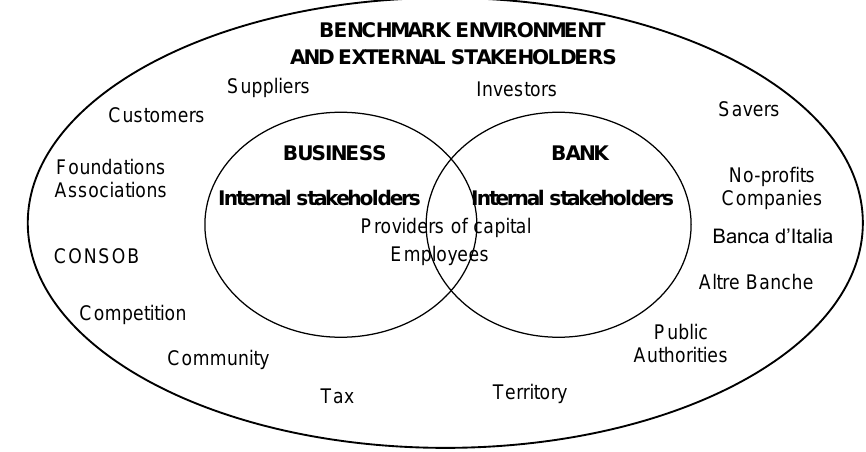
Figure 4: The Osmotic Relationship Between Businesses and Banks and Global Responsibility to